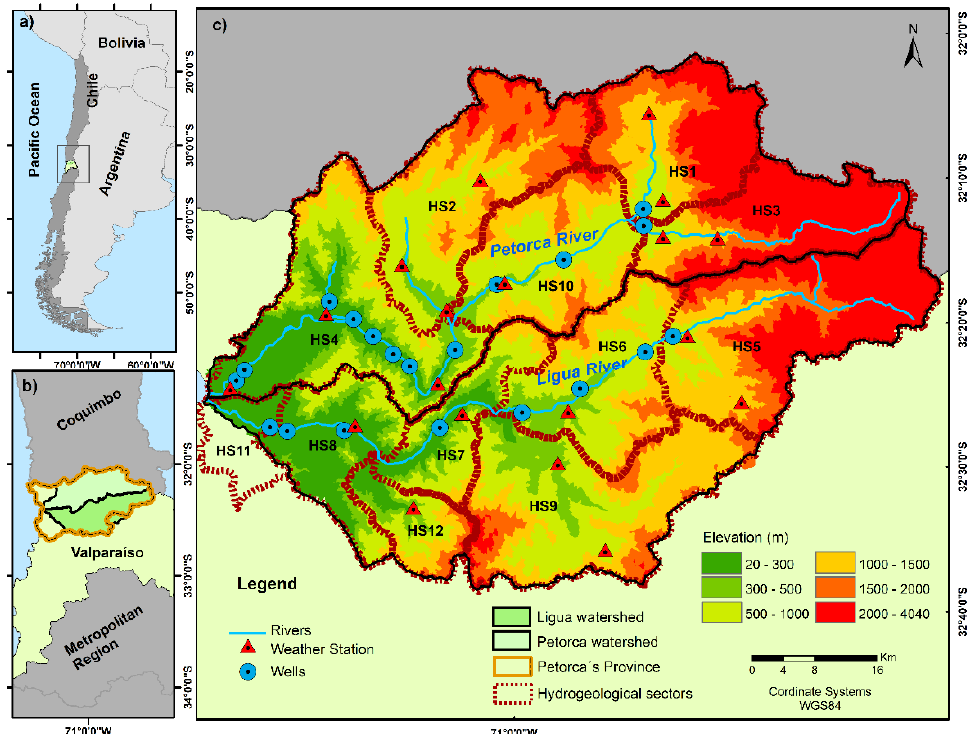
Figure 2. Location of the Ligua and Petorca watersheds; ( a ) shows the geographic setting in South America, ( b ) the geographic setting in Chile and the Petorca Province, and ( c ) wells, weather stations, hydrogeological sectors (HS), and elevation.